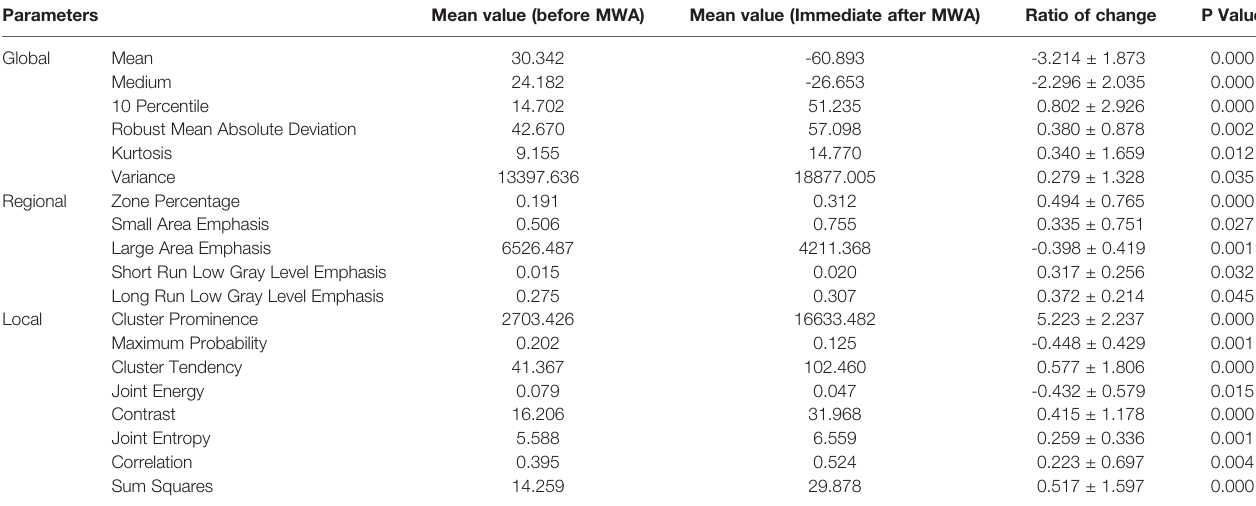
TABLE 2 | Immediate change of tumor density after MWA characterized by radiomics features.